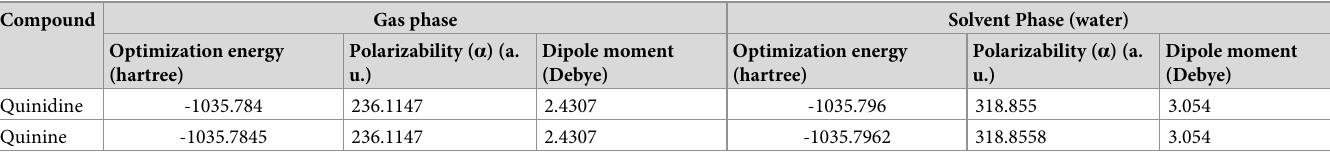
Table 1. Calculation of energetic parameters and quantum chemical descriptors of quinolone